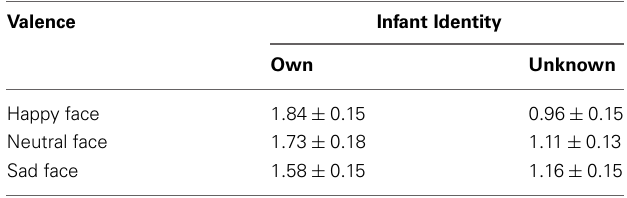
Table 2 | Mothers’ amygdala BOLD responses to infant face